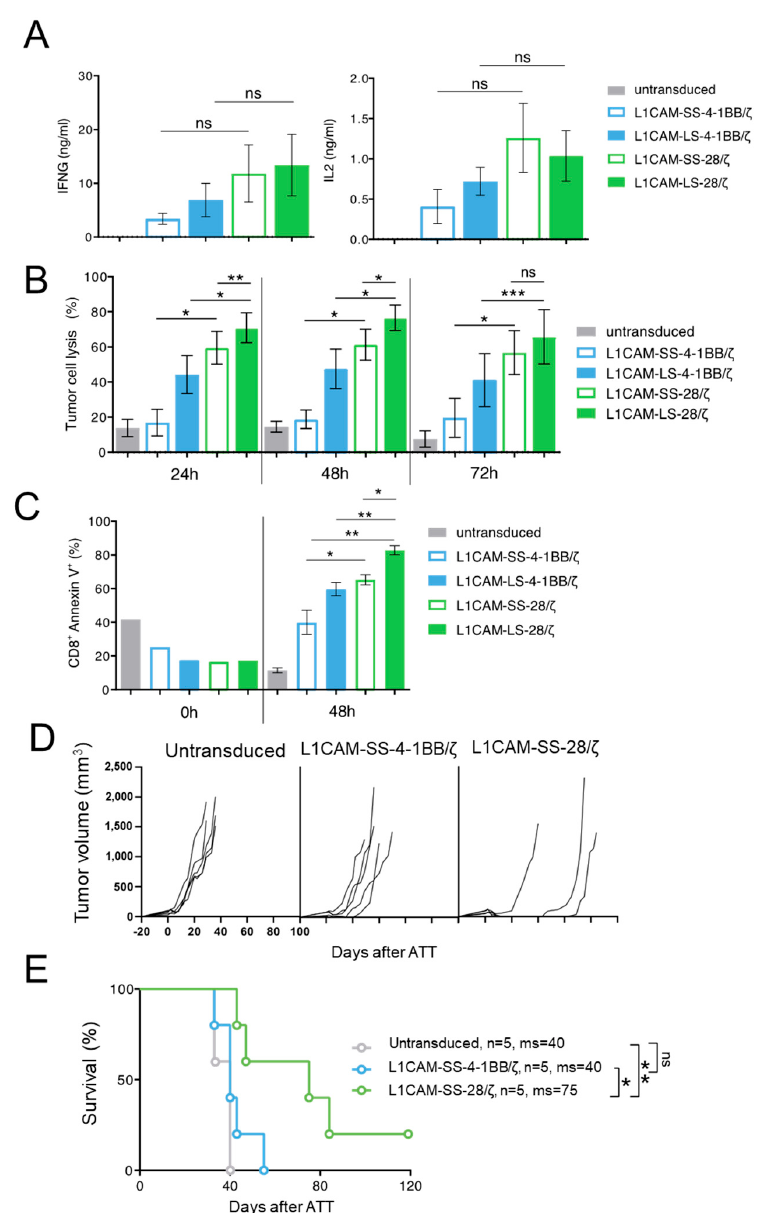
Figure 3. The superior function of CD28-based CAR T cells can be confirmed in a PDX mouse model using human T cells. ( A ) IFNG and IL2 cytokine secretion after 24 h co-culture of untransduced T cells or different L1CAM-specific CAR T cell constructs with SK-N-BE(2) target cells in an effector to target (E:T) ratio of 1:5 assessed by ELISA ( n = 3); Error bars represent SD. ( B ) Cytolytic activity of the four L1CAM-specific CAR T cell subgroups against SK-N-BE(2) neuroblastoma cells determined by luciferase-based killing assay following a co-culture for 24, 48 and 72 h at an E:T ratio of 1:5. Data shown here, depict the mean cytolytic activity of 3 independent experiments. Error bars represent SD. ( C ) Quantification of apoptosis of CAR T cells by annexin V staining before and after co-culture with SK-N-BE(2) cells for 48h in an E:T of 1:5. by two tailed paired t test. ( D ) NOG mice with subcutaneous neuroblastoma PDXs were treated by intravenous injection of 1 × 10 7 L1CAM-specific SS-4-1BB/ ζ ( n = 5), SS-28/ ζ ( n = 5) CAR or untransduced ( n = 5) T cells on three consecutive days. Each line represents change in tumor volume of an individual mouse over the period of the experiment. ( E ) Kaplan–Meier survival analysis of mice shown in ( D ). ns = not statistically significant; ms = median survival, *, p ≤ 0.05; **, p ≤ 0.01; ***, p ≤ 0.005, Kaplan–Meier survival analysis with log-rank